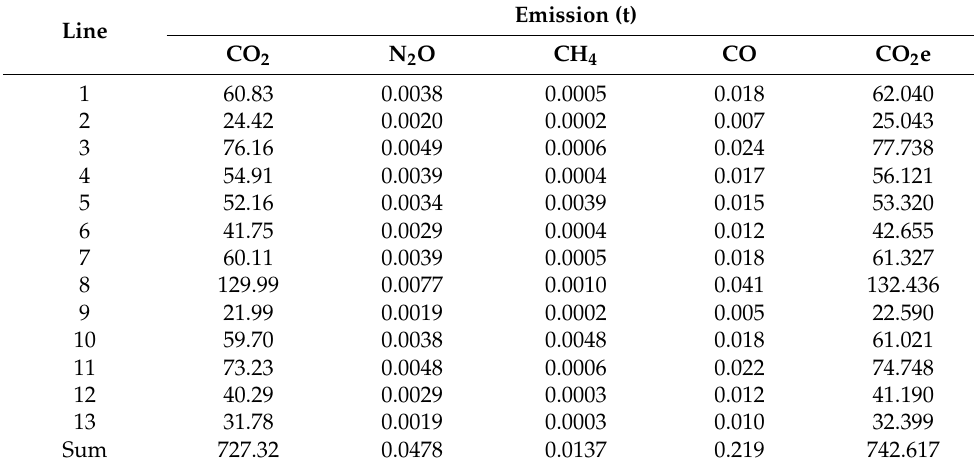
Table 7. Greenhouse gas emission calculation results for new EURO VI buses in variant V1.